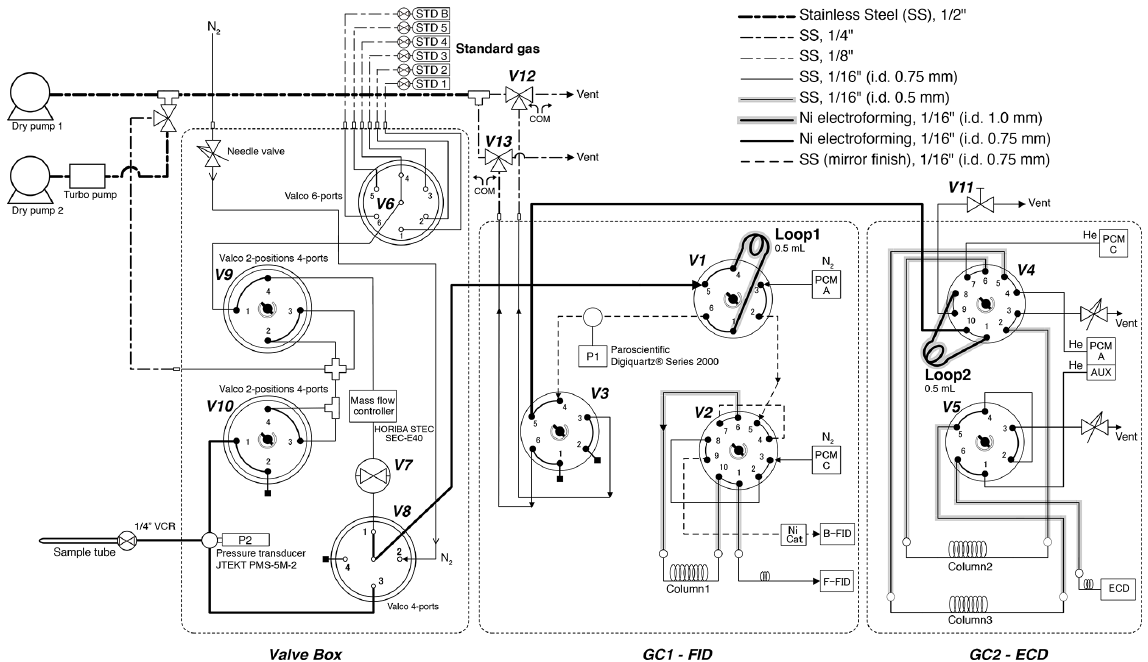
Figure 3. Schematic diagram of gas chromatographs and inlet. All two-position valves are in “off” positions.